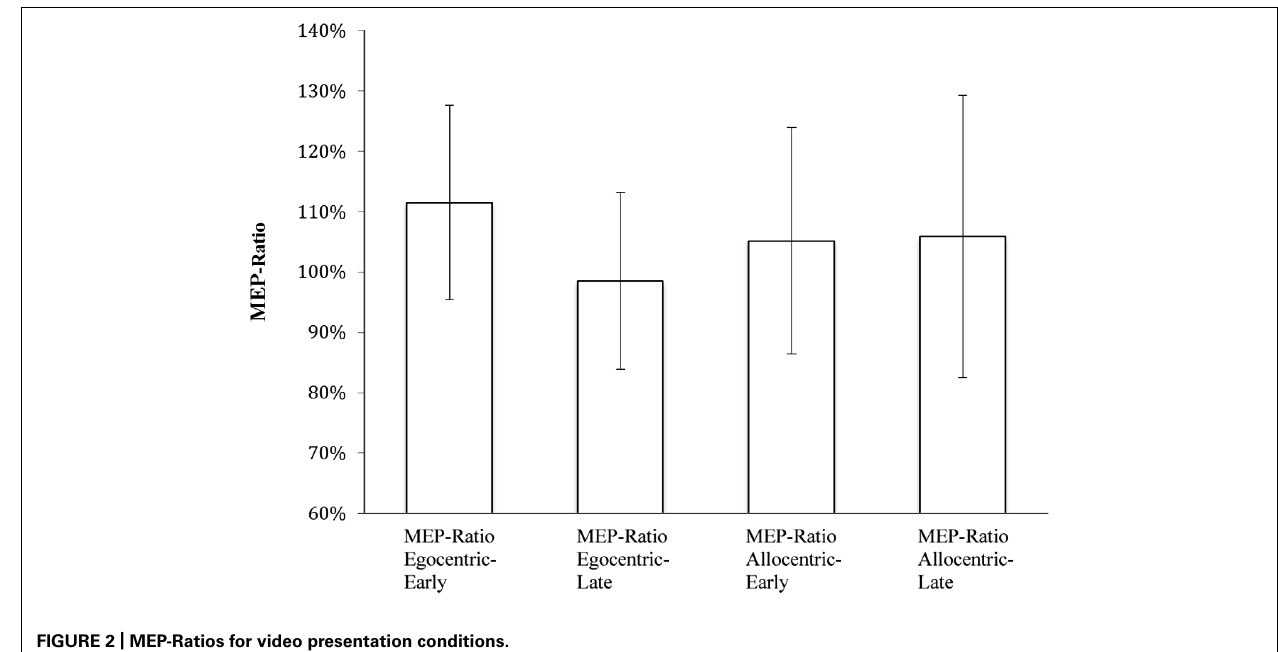
FIGURE 2 | MEP-Ratios for video presentation